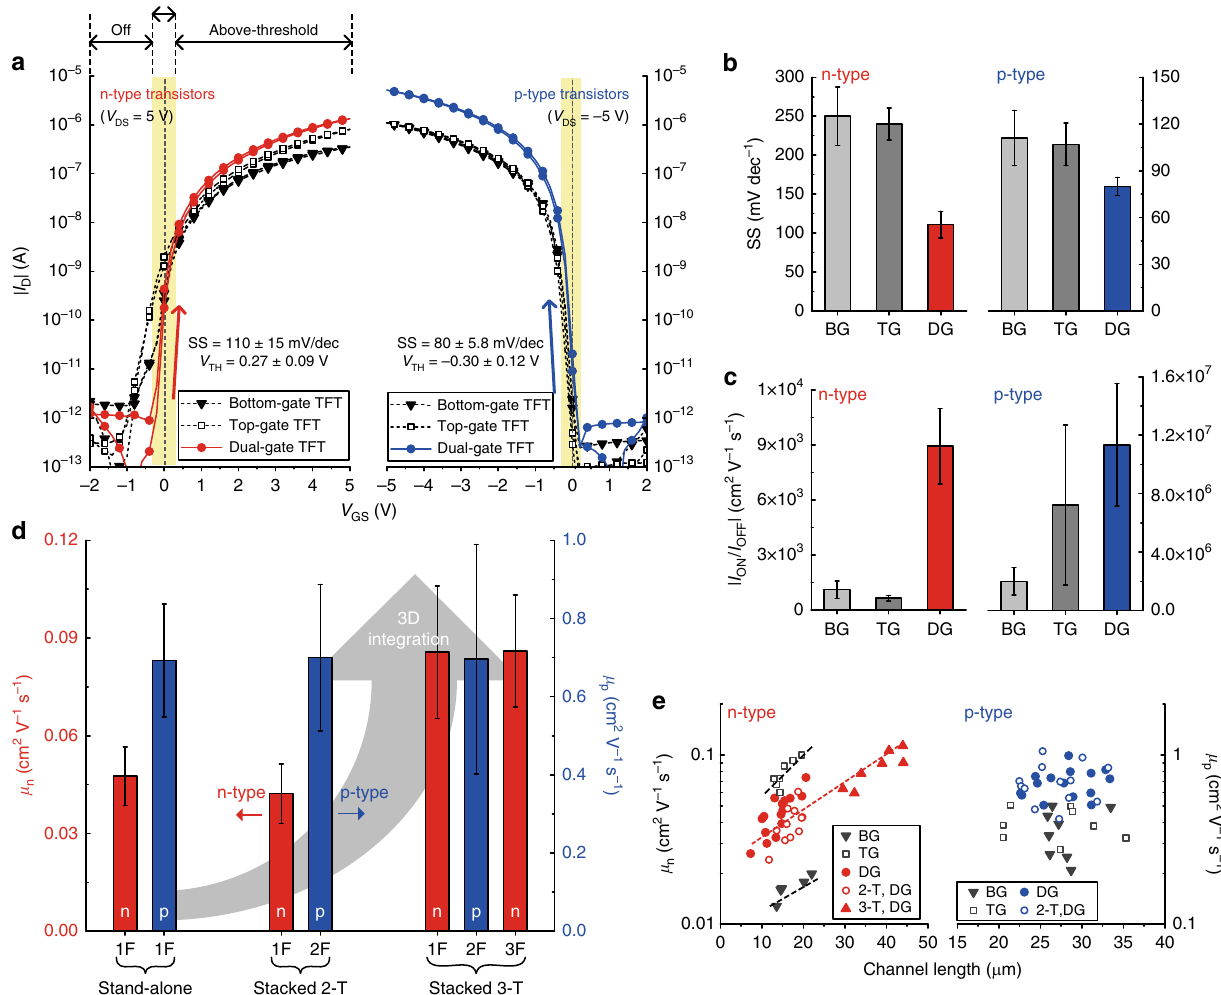
Fig. 3 Device characteristics. a | I D | – V GS transfer characteristics of the n-type and p-type organic transistors in single-gate (bottom-gate and top-gate) and dual-gate con fi gurations. b The subthreshold swings and c the I D on-off ratios. d The extracted carrier mobilities in the 3D-integrated complementary organic transistors. e The channel length dependency of the extracted carrier mobilities. Error bars represent standard